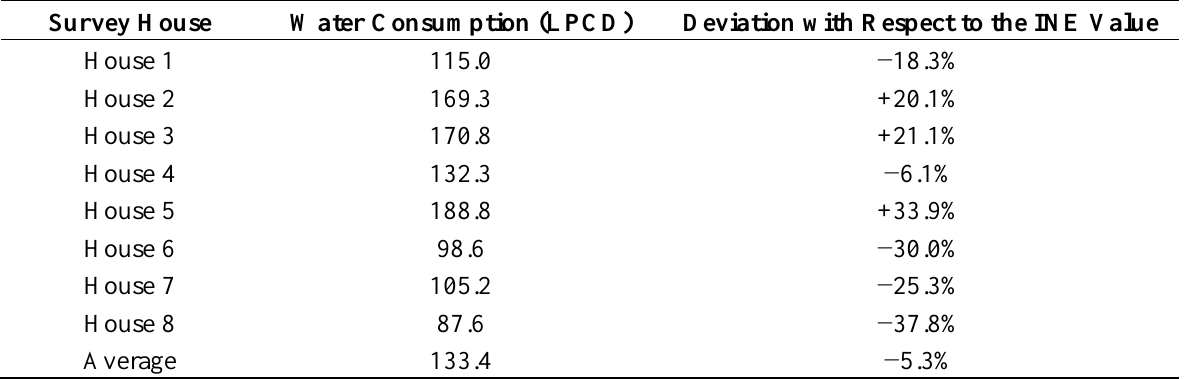
Table 6. Comparison between survey and National Statistical Office (INE)